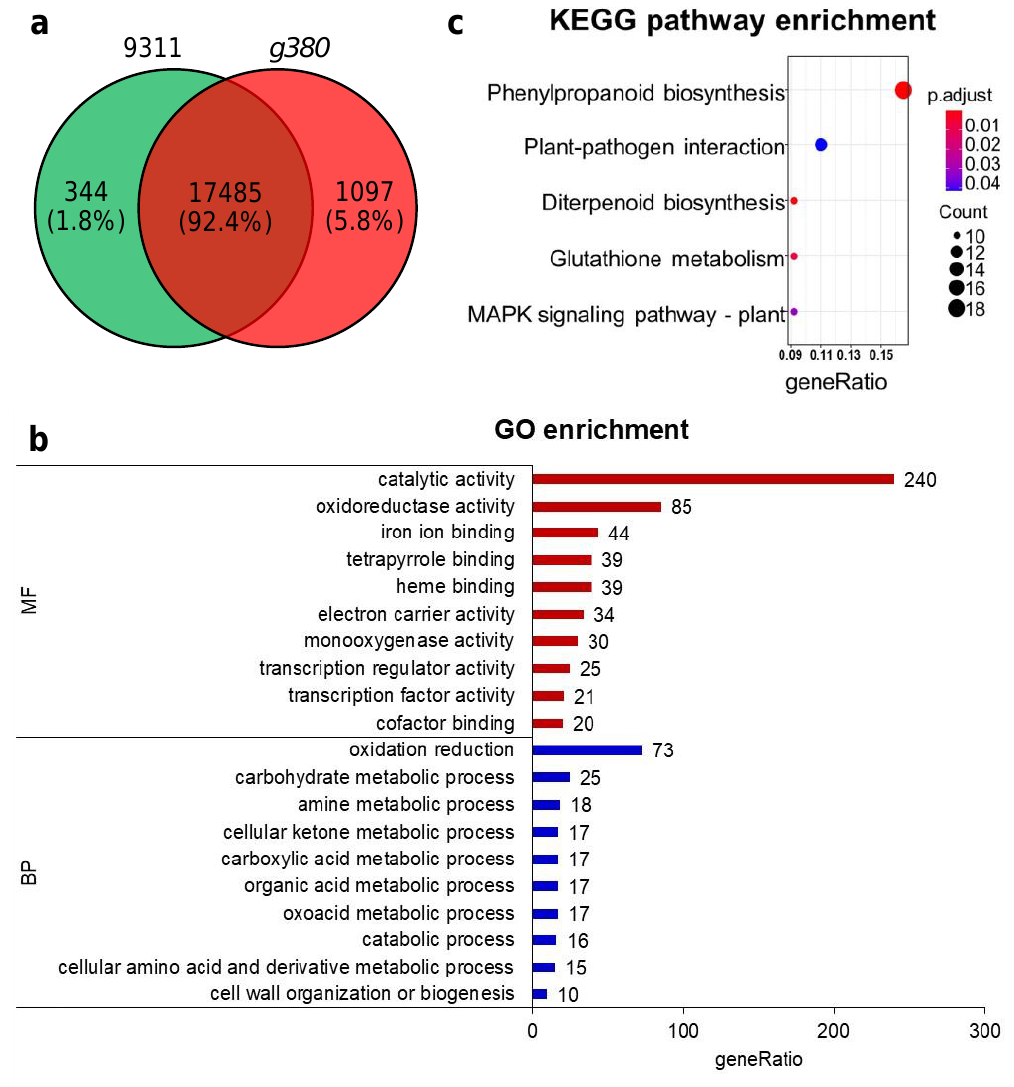
Figure 5. Expressed gene statistics and GO and KEGG pathway enrichment analysis of DEGs. ( a ) Venn diagram of 9311 and g380 expressed genes. ( b ) GO enrichment analysis of upregulated DEGs; the top ten terms enriched in BP and MF. BP: biological process; MF: molecular function. ( c ) KEGG pathway enrichment analysis of up-regulated DEGs .